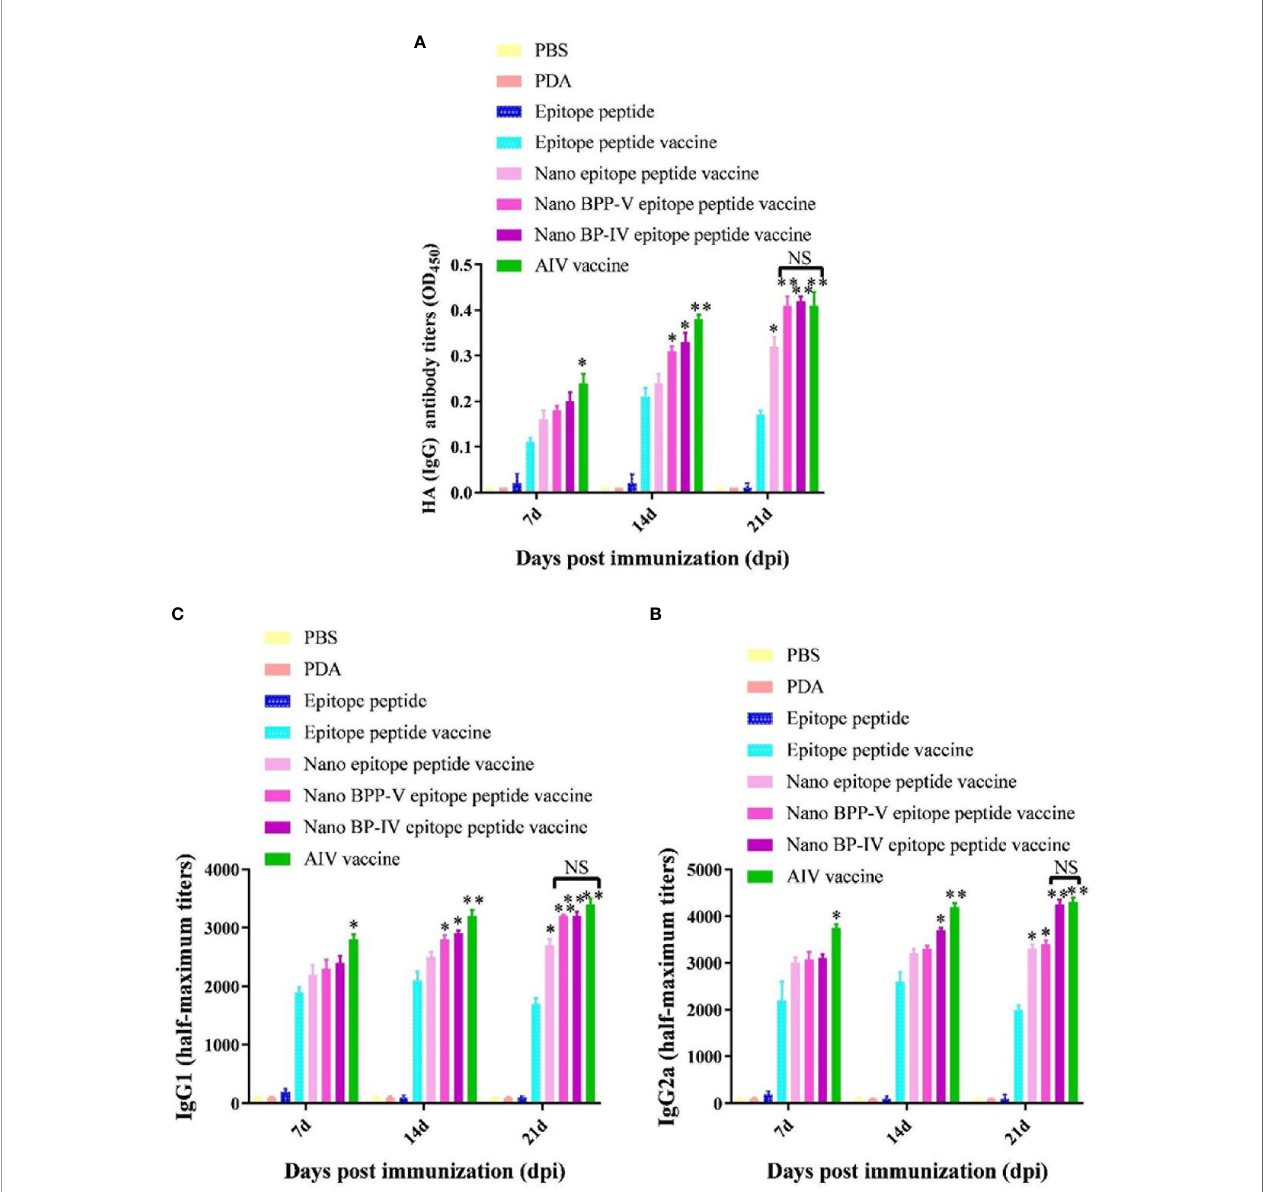
FIGURE 5 | The nano BPP-V and BP-IV epitope peptide vaccines promoted the secretion of anti-HA (IgG) (A) , IgG1 (B) and IgG2a (C) antibodies in the sera of immunized mice. The immunized mouse serum samples were collected on days 7, 14, and 21 after immunization, and the levels of anti-HA (IgG), IgG1, and IgG2a were detected by ELISA method. * P < 0.05 and ** P < 0.01, compared with the epitope peptide vaccine group. NS indicates no signi fi cant